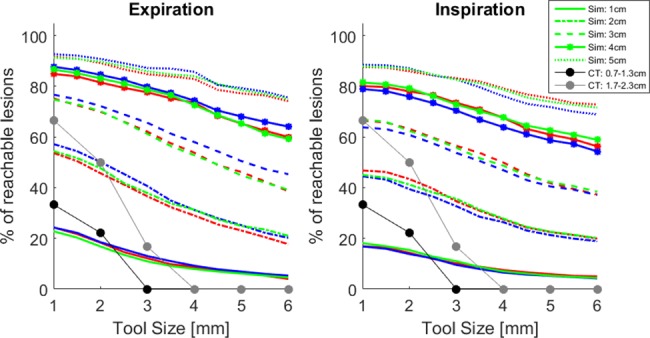
Percentage of lesions within reach of different sized tools if the tool remains inside the airways.Colors indicate the three simulated models (1- red, 2 –blue, 3 –green) and the type of line represents the targeted lesion diameter; black and gray are the CT data for lesions of 0.7–1.3cm and 1.7–2.3cm diameter respectively.